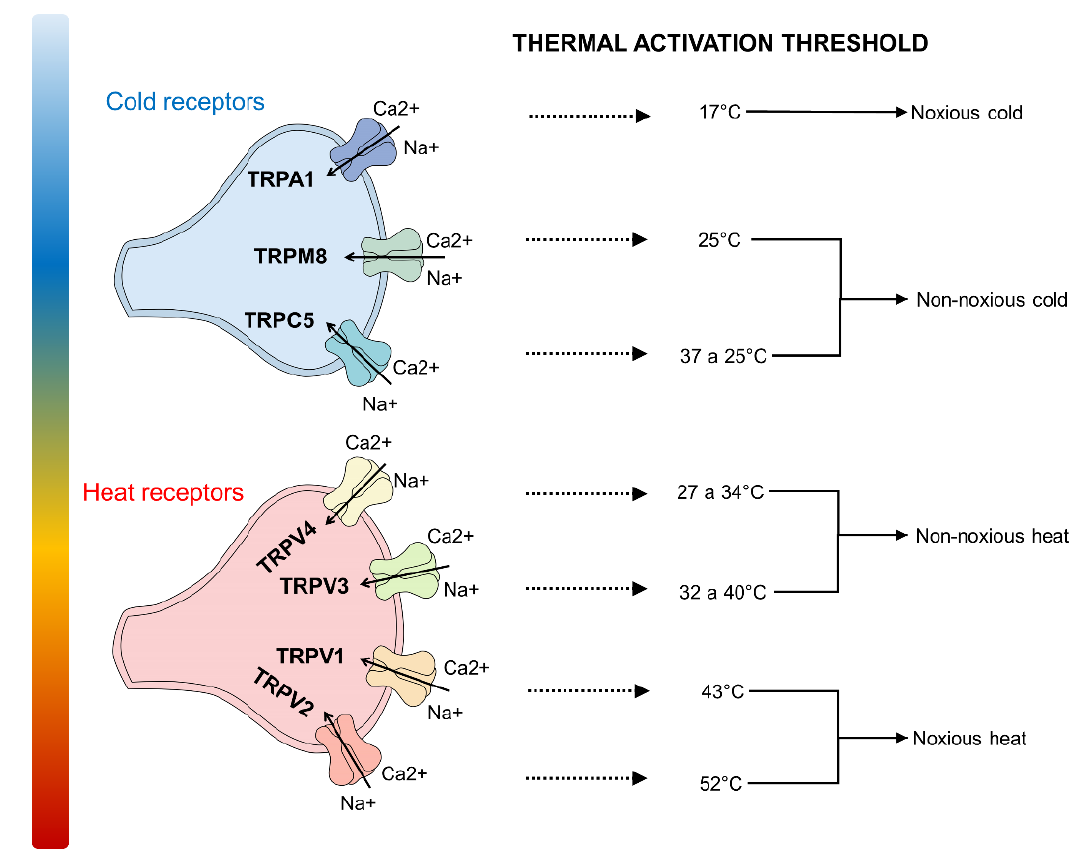
Figure 2. Thermosensitive TRP channels. Two types of thermoreceptors are known in mammals: those activated with warm or hot temperatures (range 27 – 52 °C) and can perceive harmful and non-harmful heat, and those whose activation threshold depends on cold stimuli (range 17 – 25 °C). Ca 2+ : calcium; Na + : sodium.